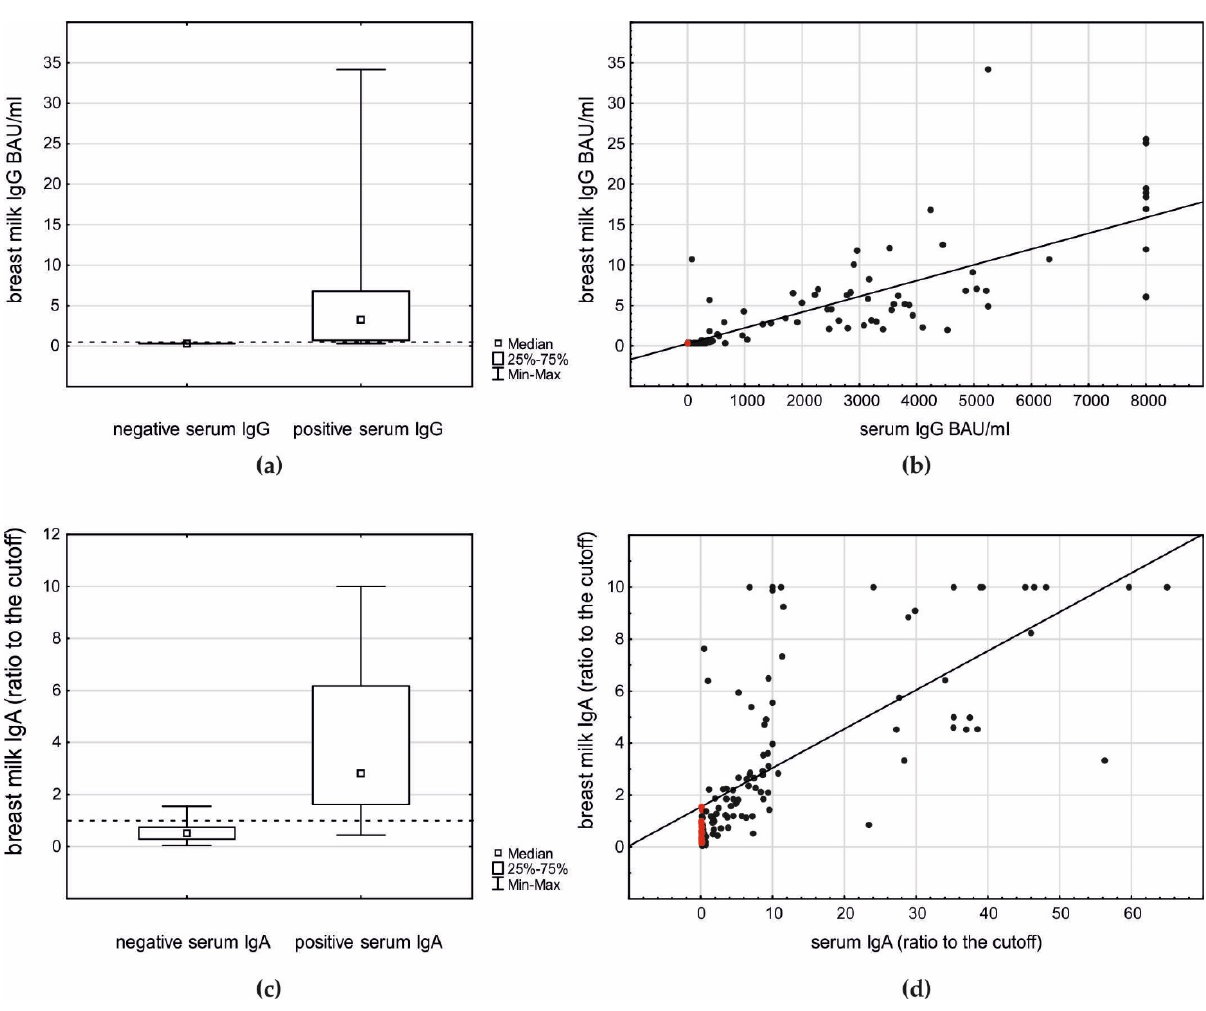
Figure 1. The relationship between breast milk IgG and IgA antibodies and their serum levels in postvaccination samples: ( a ) breast milk IgG level related to the antibody presence in serum (Mann–Whitney U test p < 0.001); ( b ) correlation between serum and breast milk IgG (r S 0.89, p < 0.001): red dots—control group; black dots—study group; ( c ) breast milk IgA level related to the antibody presence in serum (Mann–Whitney U test p < 0.001); and ( d ) correlation between serum and breast milk IgA (r S 0.83, p < 0.001): red dots—control group; black dots—study group.